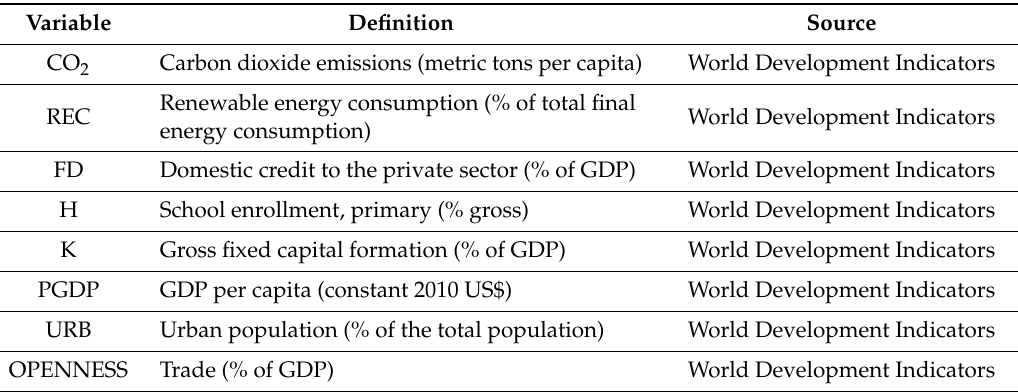
Table 3. Variable description and data sources.